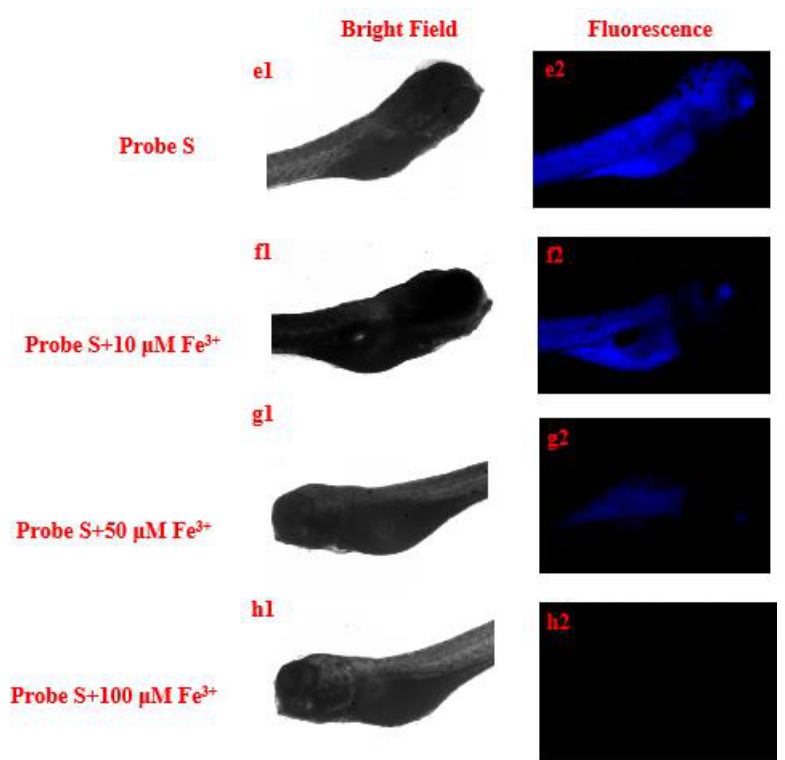
Figure 11. Bright-field and fluorescent images of zebrafish incubated with probe S (10.0 μM) ( e1 , e2 ), further incubated with addition of Fe 3+ (0, 10.0, 50.0, 100.0 μM) ( f2 , g2 , h2 ), and their corresponding bright field images ( f1 , g1 , h1 ) (the scale bar is 500 µm).